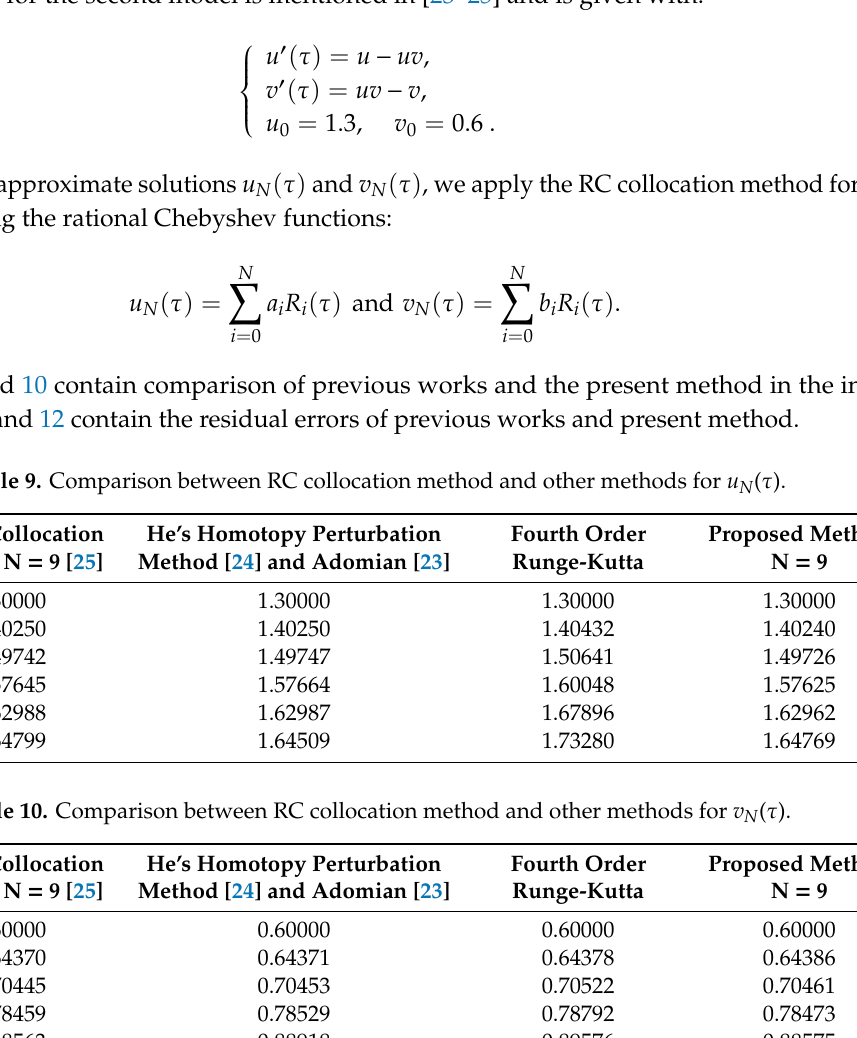
Figure 5 . Approximate solution